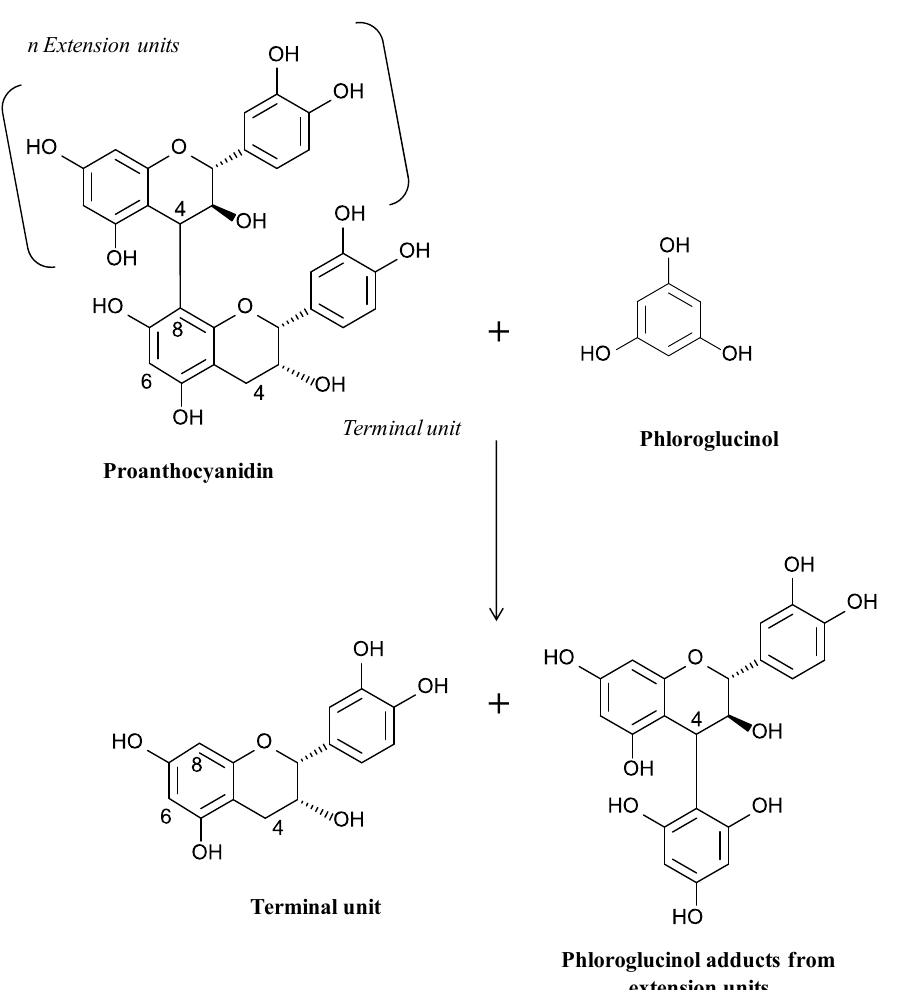
Figure 6. Reaction pathway of